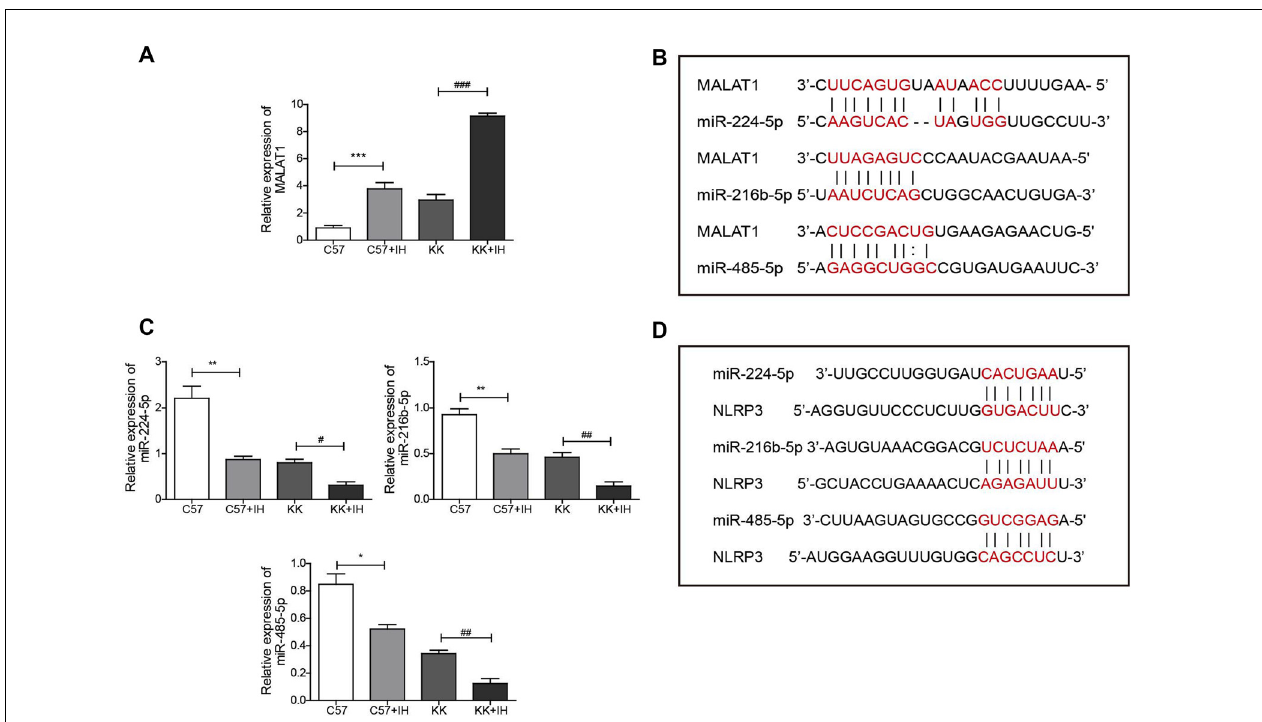
FIGURE 2 | IH upregulated MALAT1 and downregulated miRNAs in the brains of T2DM mice. (A,C) MALAT1 and the miRNAs miR-224-5p, miR-216b-5p and miR-485-5p were analyzed by qRT-PCR. (B) Base-pairing sites for MALAT1 and miR-224-5p, miR-216b-5p and miR-485-5p. (D) Base-pairing sites for miR-224-5p, miR-216b-5p and miR-485-5p with NLRP3. All results are presented as the mean ± SEM. * p < 0.05, ** p < 0.01, *** p < 0.001 vs. the C57 group; # p < 0.05, ## p < 0.01, ### p < 0.001 vs. the KK+IH group.